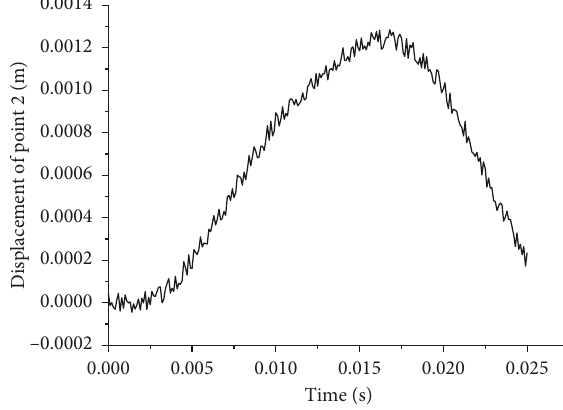
Figure 10: Displacement response of point 2 by F Figure 11. The red dot indicates the regularization parameter α � 0 . 0054.